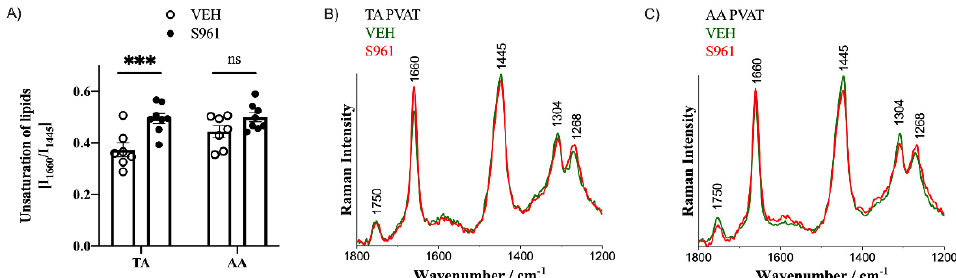
Figure 5. Effects of S961 treatment on adipose tissue chemical characteristics by Raman spectroscopy. Analysis ( A ) and averaged Raman spectra ( B , C ) of the lipid unsaturation degree (I 1660 /I 1444 ) in TA and AA PVAT (in C57Bl/6 mice given vehicle (green; n = 5) or S961 (red; n = 5) via osmotic pumps for 2 weeks. Statistical significance tested using two-sided Student’s t -test with Welch’s correction, normality confirmed by Shapiro–Wilk test, variance by F-test: *** p < 0.005.